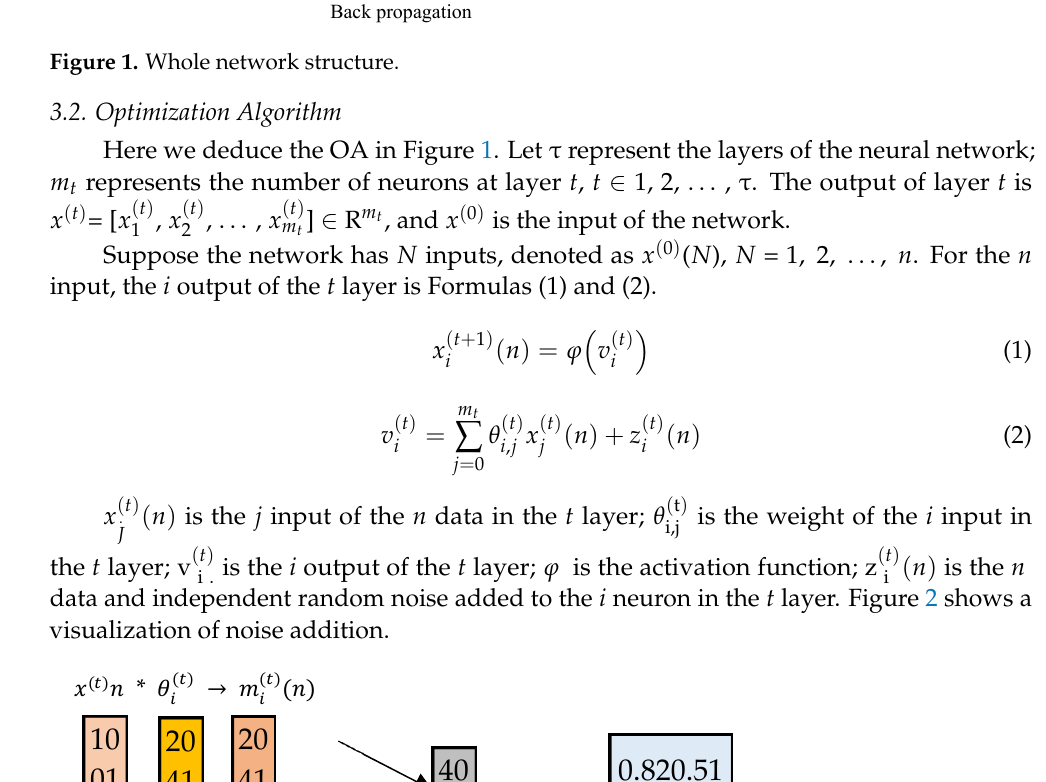
Figure 1. Whole network structure.